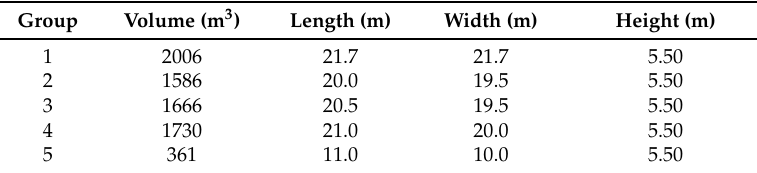
Table 7. Dimensions of the storage tanks for rainwater and